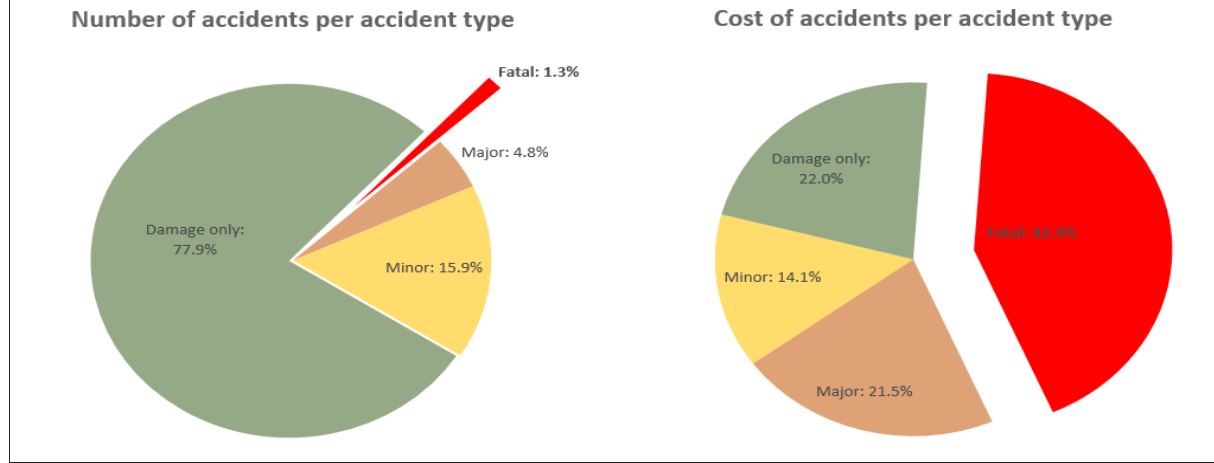
Figure 2: Breakdown of (a) the number of accidents and (b) costs involved per accident type, for the road accidents that occurred in South Africa during 2015.